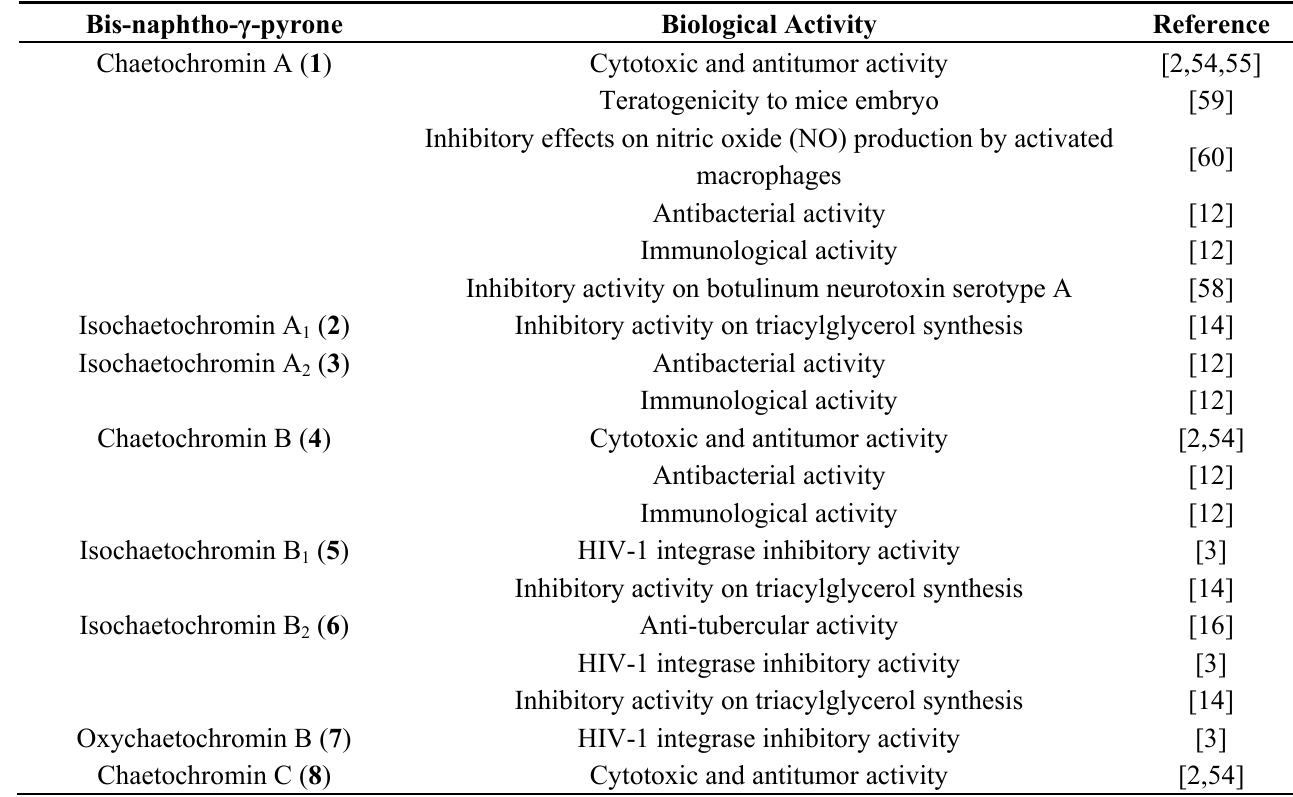
Table 5. Biological activities of bis-naphtho- γ -pyrones from